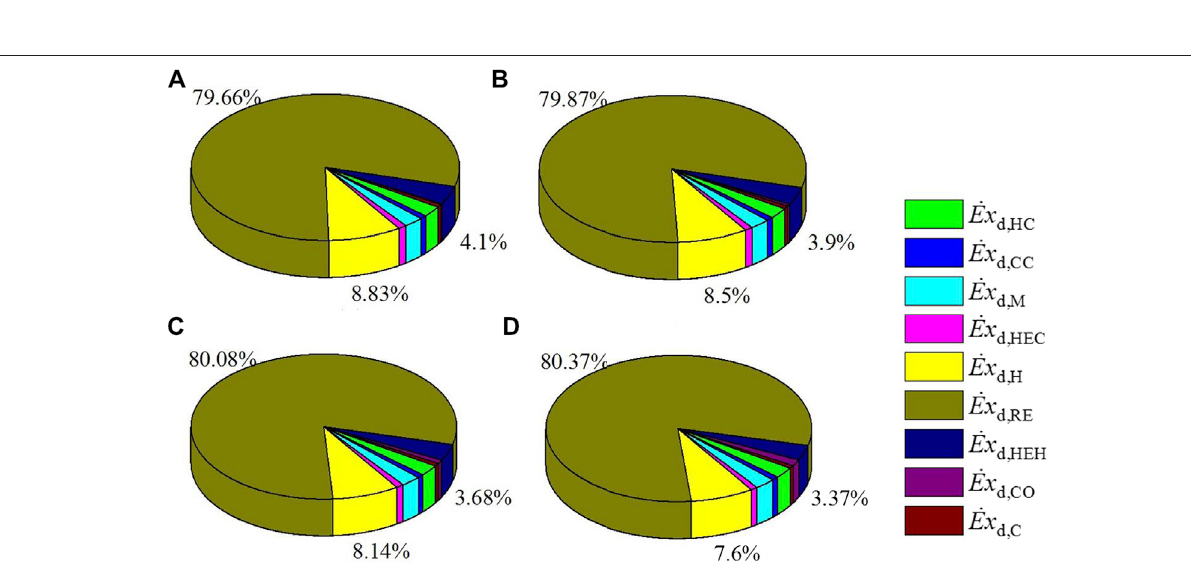
Frontiers in Energy Research |